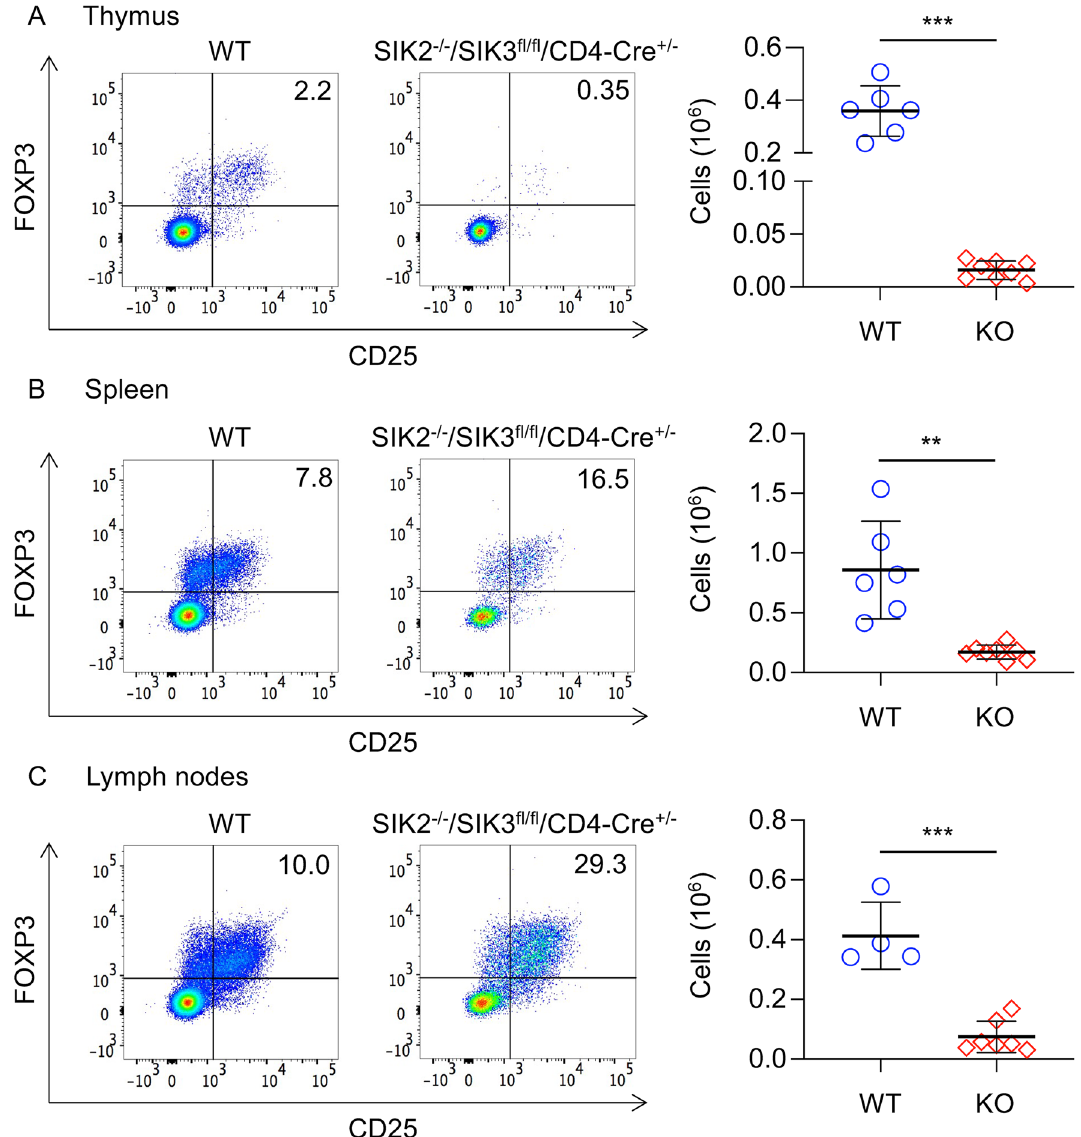
Figure 10. Analysis of Tregs in SIK2 -/- /SIK3 fl/fl /CD4-Cre +/- mice. Thymi, spleen and lymph nodes were isolated from wild type (WT) and SIK2 −/− /SIK3 fl/fl /CD4-Cre +/− (KO) mice. Cells were stained for TCRβ, CD4, CD25 and FoxP3. Tregs were identified as TCRβ +ve /CD4 +ve /CD25 +ve /FoxP3 +ve cells. Representative CD25 / FoxP3 plots of live gated TCRβ +ve /CD4 +ve cells are shown along with absolute numbers of Tregs are shown for thymus ( A ), spleen ( B ) and lymph nodes ( C ). Differences in cell number between wild type and knockout mice were analysed by Student’s t-test. p < 0.01 by ** and < 0.001 by ***. Data show results from 6 wild type and 8 knockout mice for the thymus and spleen and 4 wild type and 7 knockout mice for the lymph